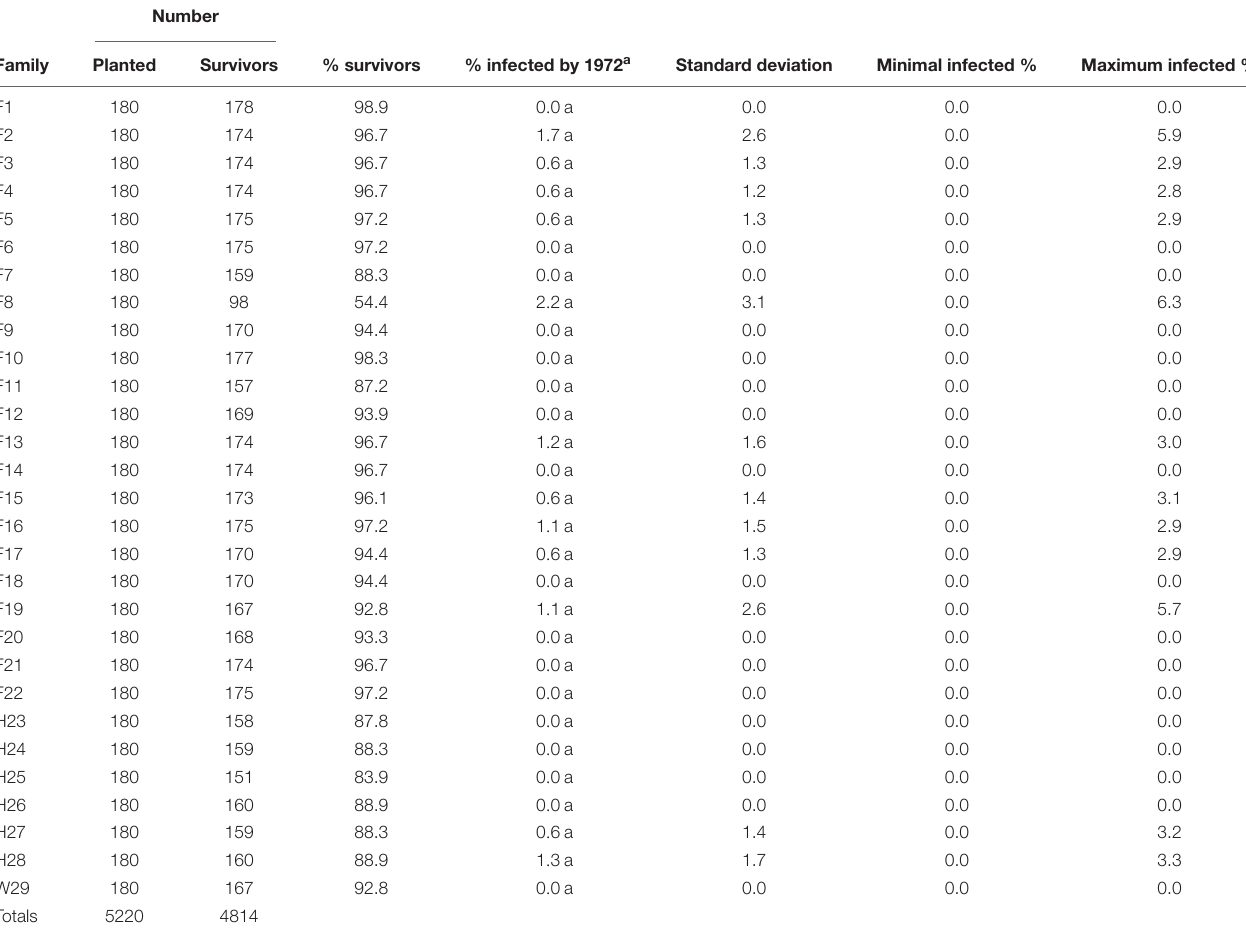
Data above are percentages, but statistical test applied to arcsine transformed fractions. a Averages with the same letters are not significantly different at α = 0.05 (arcsine transformation of percentage data, followed by ANOVA and Tukey’s HSD test for unequal